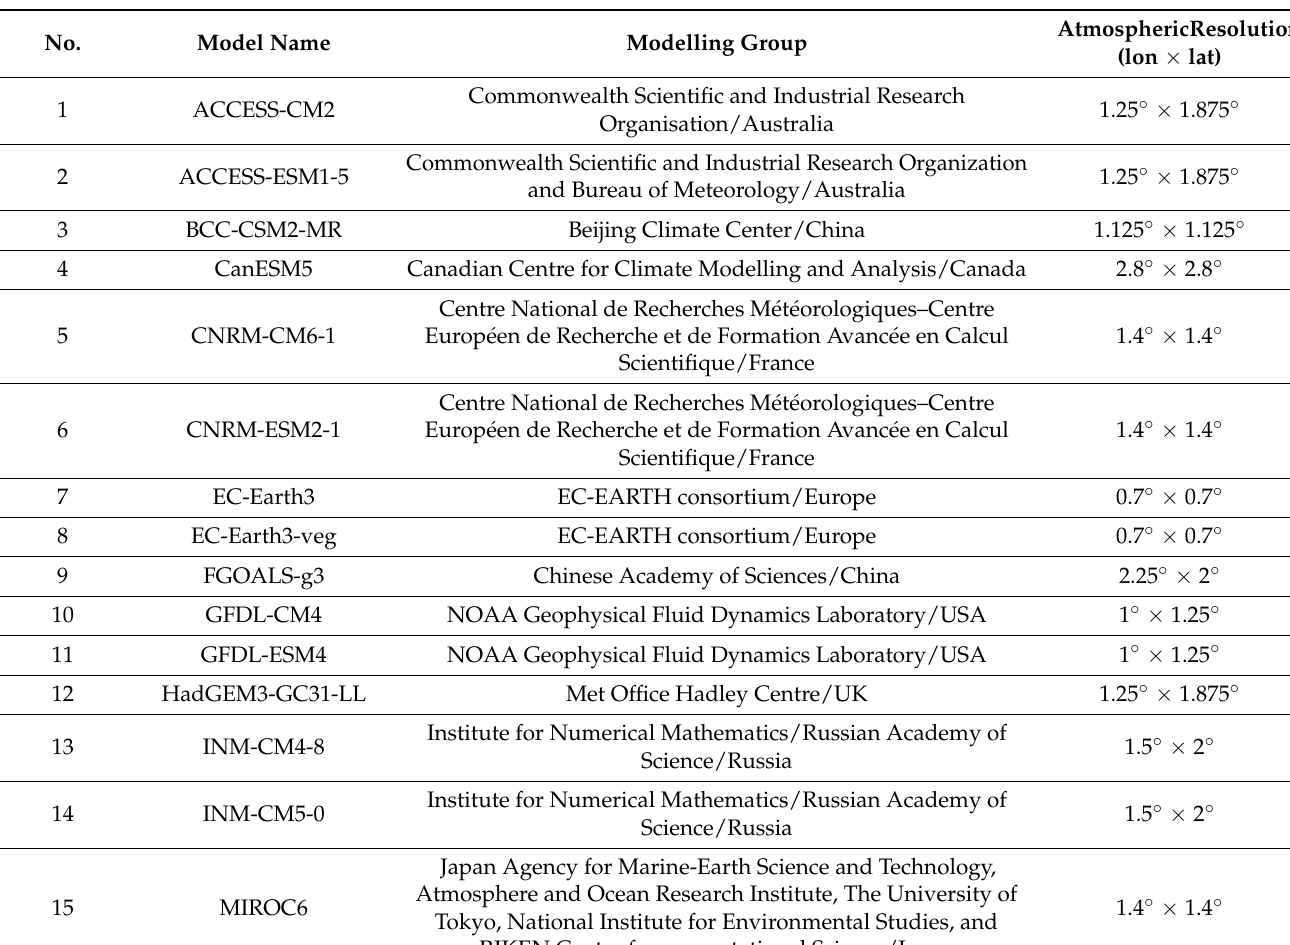
Table 1. List of the CMIP6 General circulation models (GCMs) models used in this study.